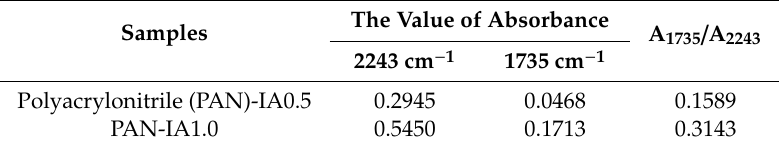
Figure 3. Fourier Transform Infrared Spectroscopy (FTIR) spectra of ( a ) PAN homopolymer, ( b ) PAN-IA0.5 copolymers, and ( c ) PAN-IA1.0 copolymers ( left figure). Amplification section of –COOH groups in FTIR ( right figure). Table 1. The value of absorbance of the peak at the 2243 and 1735 cm − 1 .